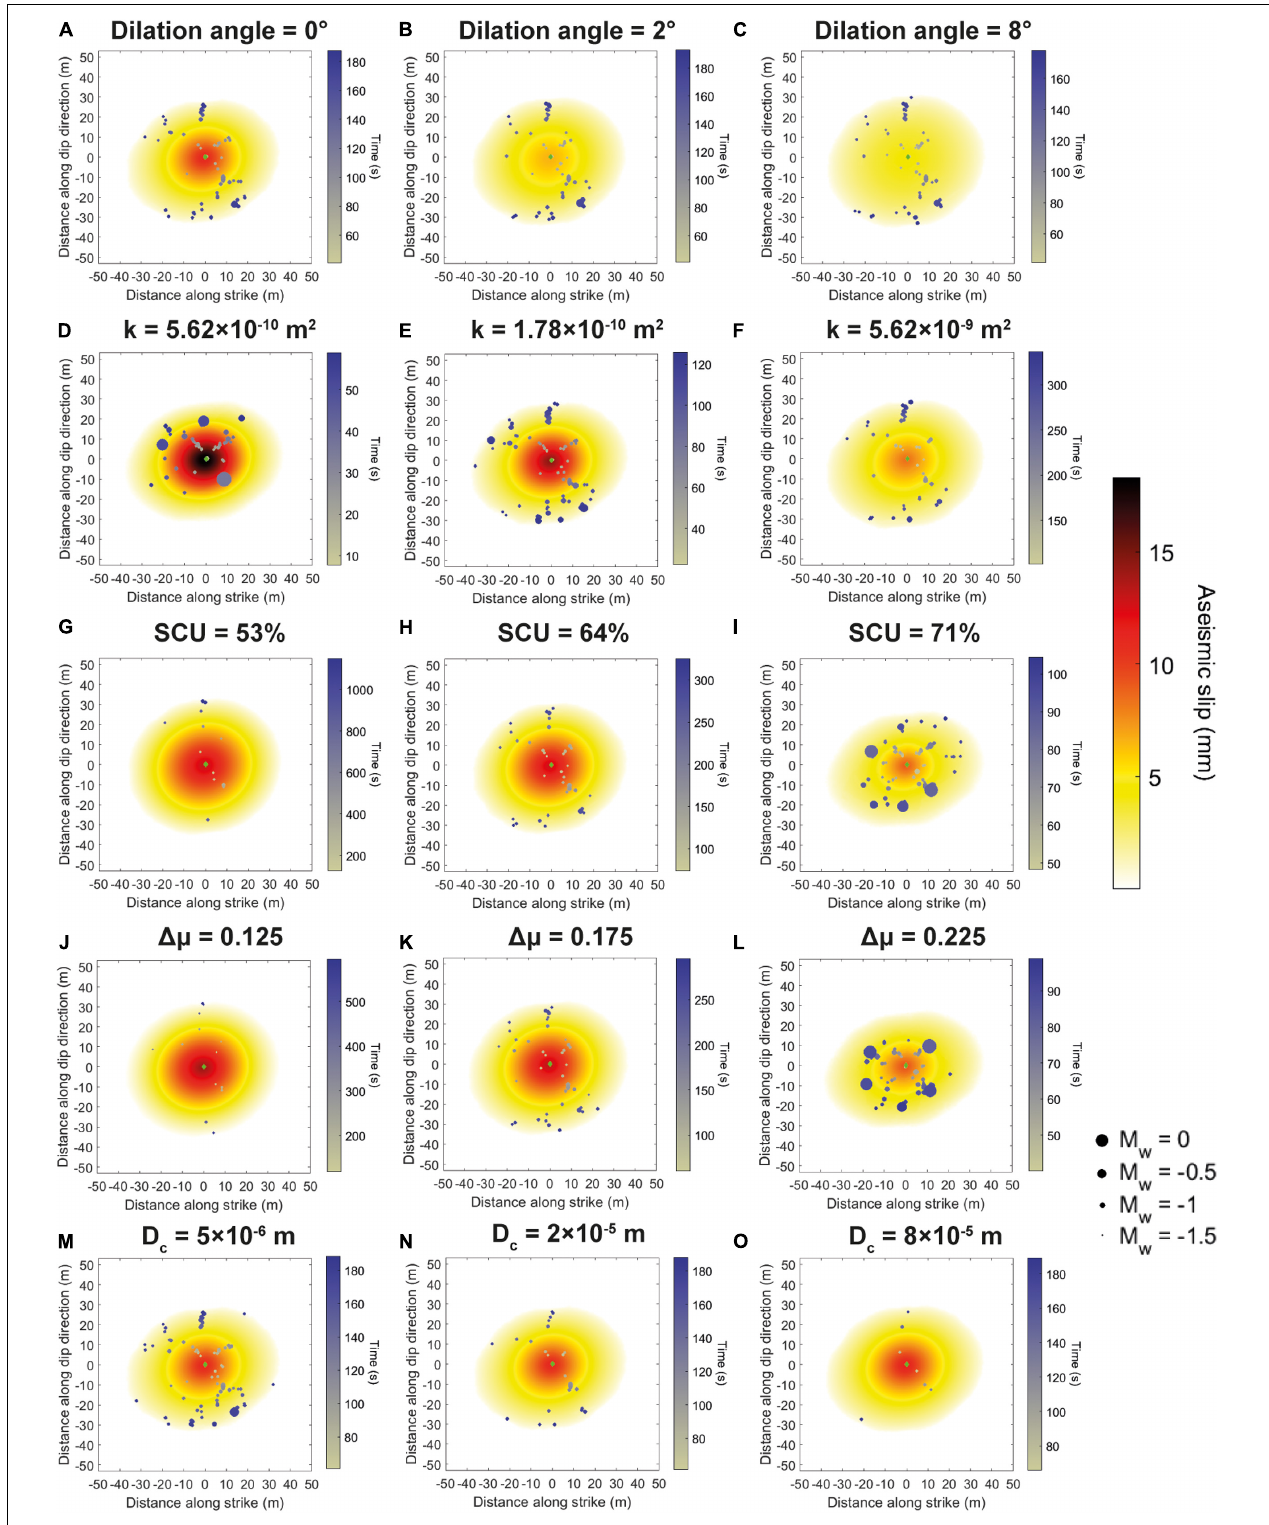
FIGURE 3 | Aseismic slip on the fault at the end of the simulations for various dilation angles ( A: 0 ◦ ; B: 2 ◦ ; C: 8 ◦ ), permeabilities ( D: 5.6 × 10 − 10 m 2 ; E: 1.8 × 10 − 9 m 2 ; F: 5.6 × 10 − 9 m 2 ), stress criticalities ( G: 53%; H: 64%; I: 71%), friction drops ( J: 0.125; K: 0.175; L: 0.225), and critical slip distances ( M: 5 × 10 − 6 m; N: 2 × 10 − 5 m; O: 8 × 10 − 5 m). The seismic events generated during the test are represented by black disks whose size is function of their magnitude.